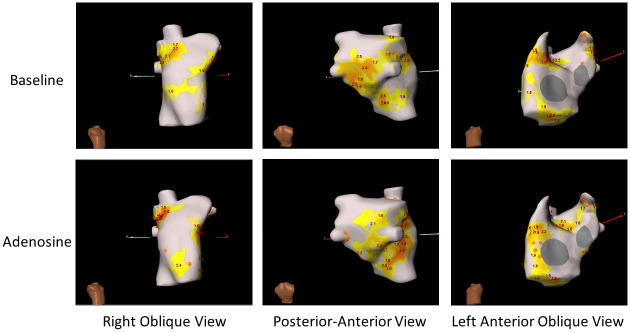
ECGI composites maps at baseline and with adenosine.ECGI Composite maps from the same patient at baseline and with Adenosine. In this figure the orange hexagons represent focal drivers and the yellow/orange areas are regions where rotational drivers have been detected. The numbers in the diagram represent the number of revolutions completed for each rotational PD occurrence in that region. the overall burden and distribution of PDs is very similar, but the proportion of PDs that are focal is arguable slightly increased in the maps following administration of adenosine.